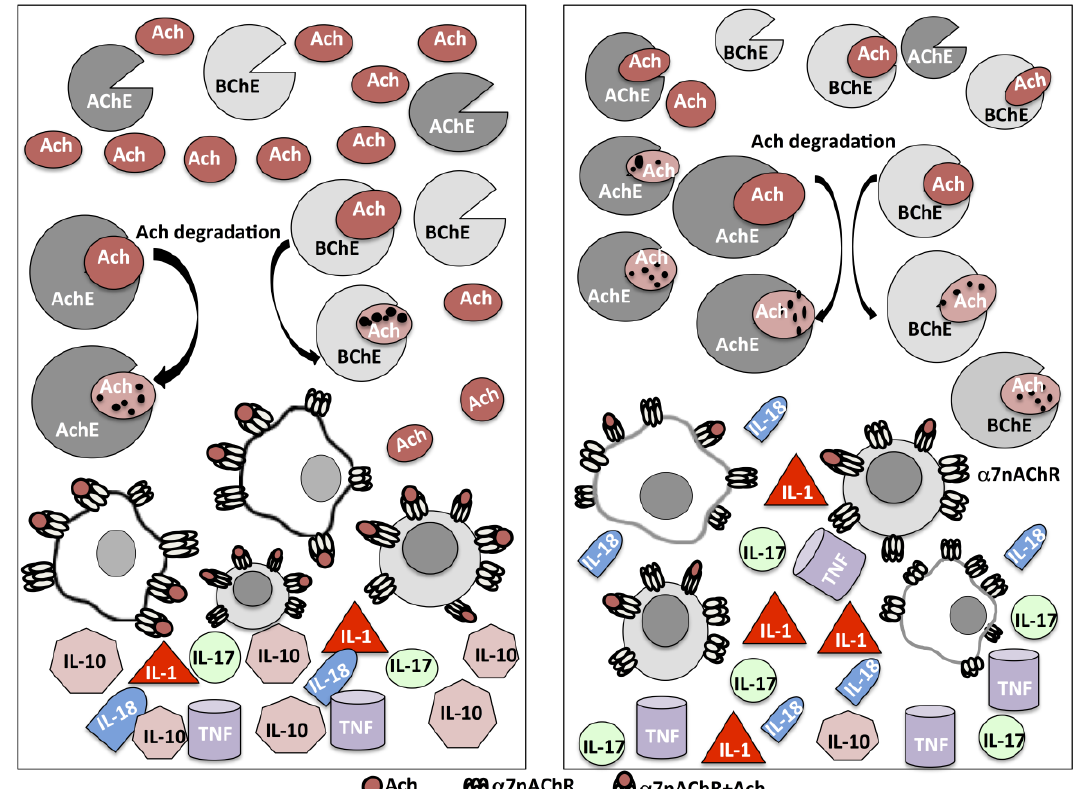
Figure 1. Schematic representation of the mechanism associated with Acetylcholine (Ach) degradation by acetylcholinesterase (AChE) and butirylcholinesterase (BChE) (see arrows), in healthy (left) and multiple sclerosis patients’ immune cells (right). The decreased ACh levels may contribute to a reduced α -7 nicotinic receptor activation and a consequent increase of pro-inflammatory cytokines.